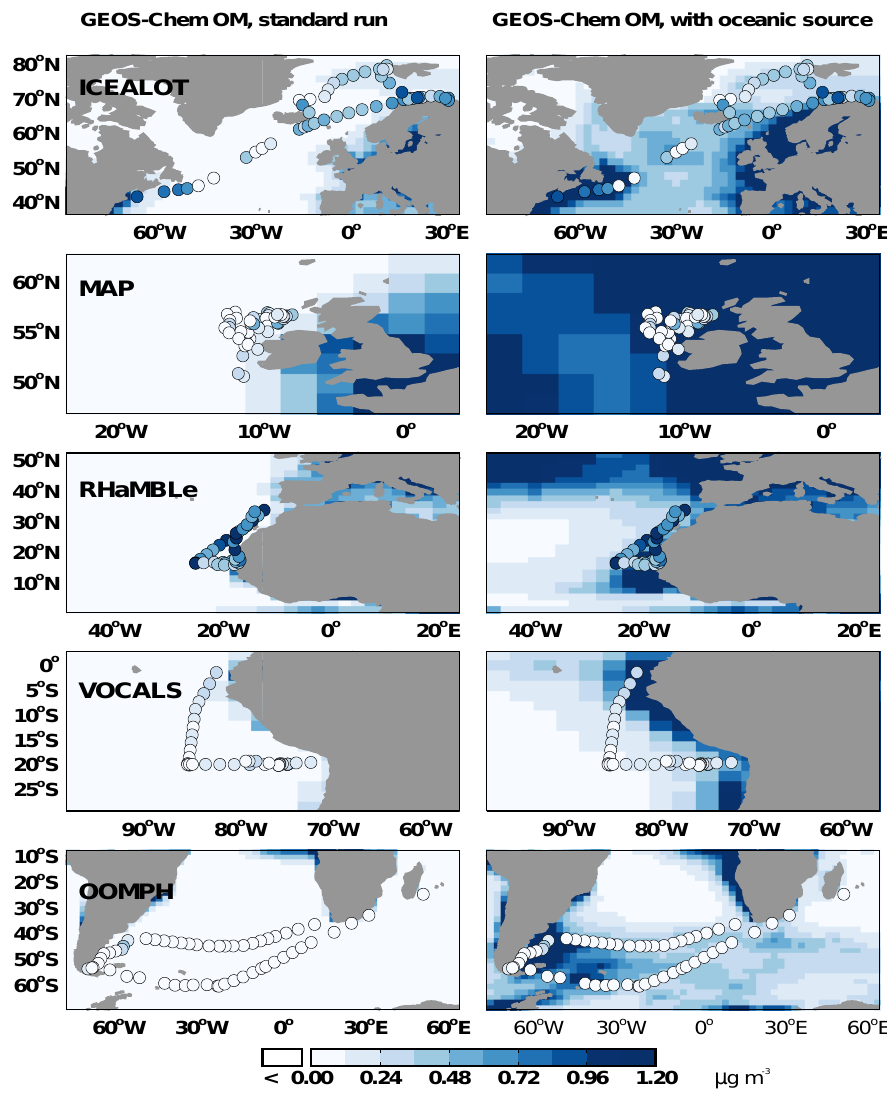
Fig. 6. Modeled surface OM concentration averaged over the period of each campaign without (left) and with (right) marine OM source by Spracklen et al. (2008) overlaid with OM observations. Color scale is saturated at the maximum values indicated in the